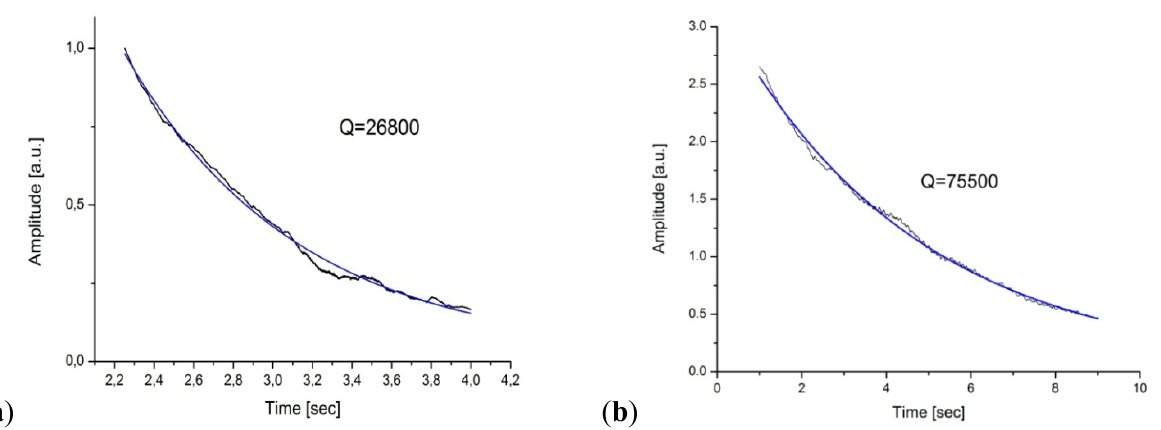
Figure 10. Resonance amplitude decay plots of different high-speed MEMS mirror resonators. ( a ) Design #1 ( b ) Design